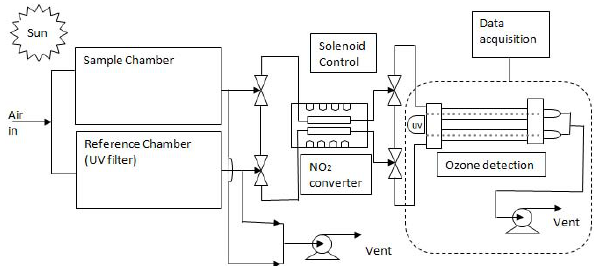
Fig. 1. Schematic of the MOPS. Equal air flows pass through the two chambers exposed to sunlight. The sample chamber passes so- lar ultraviolet light while the reference chamber has a film covering that blocks it. NO 2 converter cells enable the detection of NO 2 +O 3 by the dual-channel UV-absorption O 3